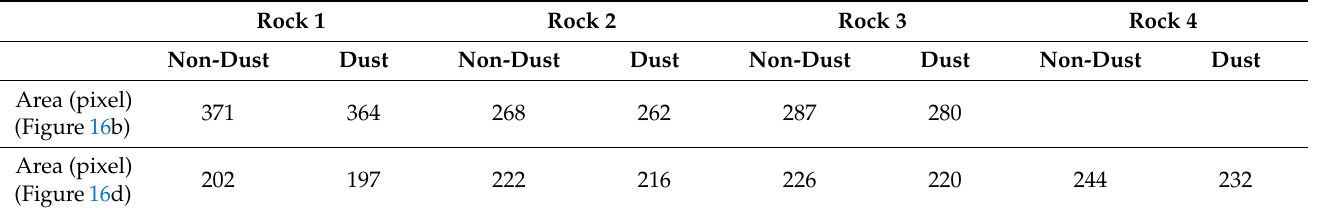
Figure 16. Experimental result of the smart hopper when the dust air environment is simulated by adjusting the image chroma and transparency. ( a ) RGB image with 3 rocks on the hopper, ( b ) binary image of detected 3 rocks, ( c ) RGB image with 3 rocks on the hopper and one rock under the hopper, ( d ) Binary image of detected 4 rocks. Table 4. Experimental results of the detected rock area according to the presence or absence of simulated dust